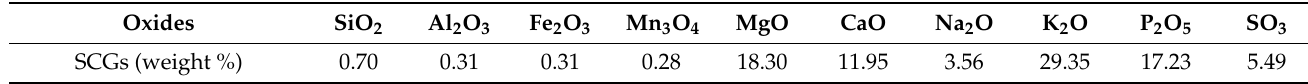
Table 5. Ash analysis of SCGs (Adapted from Biswal, et al. [58]. Reproduced with permission from Elsevier).